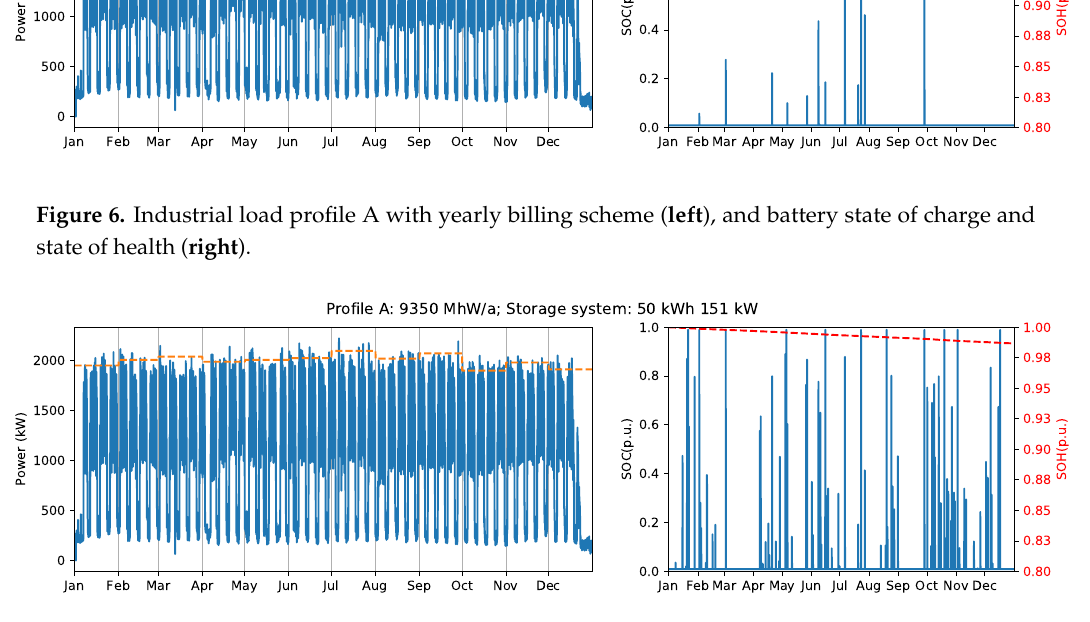
Figure 7. Industrial load profile A with monthly billing scheme ( left ), and battery state of charge and state of health ( right